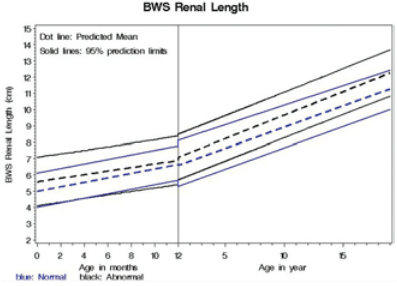
Figure 1 - Renal growth curves for normal control (blue line) age-matched population, as published by Rosenbaum et al. 6 , and patients with Beckwith- Wiedemann syndrome (BWS; black line). Renal growth is parallel and renal length increases continuously at an approximately constant rate above normal that is never above two standard deviations